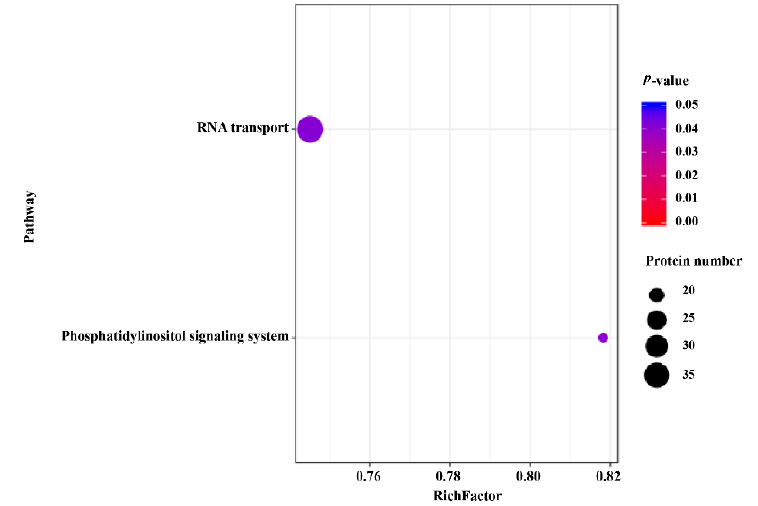
11 of 26 Figure 7. GO enrichment analysis of DEPs. ( A ) GO enrichment analysis of upregulated DEPs. ( B ) GO enrichment analysis of downregulated DEPs. The number of DEPs and GO terms are displayed on the horizontal axis and vertical axis, respectively. 2.5. KEGG Pathway Analysis Among various organisms, enzymes harboring phosphorylation sites were capable